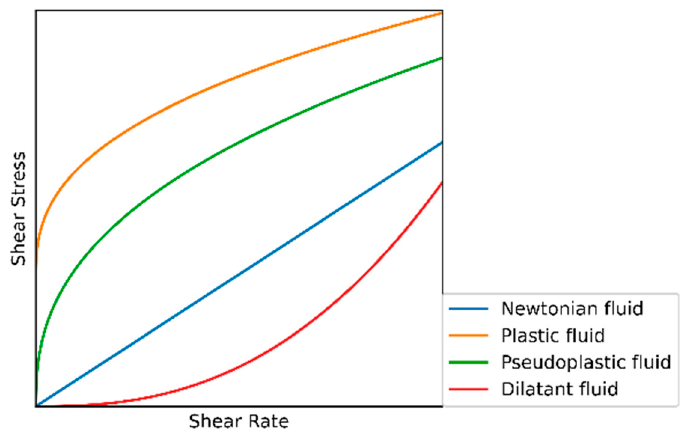
Figure 1. Rheological curves of Newtonian fluid, plastic fluid, pseudoplastic fluid, and dilatant fluid.